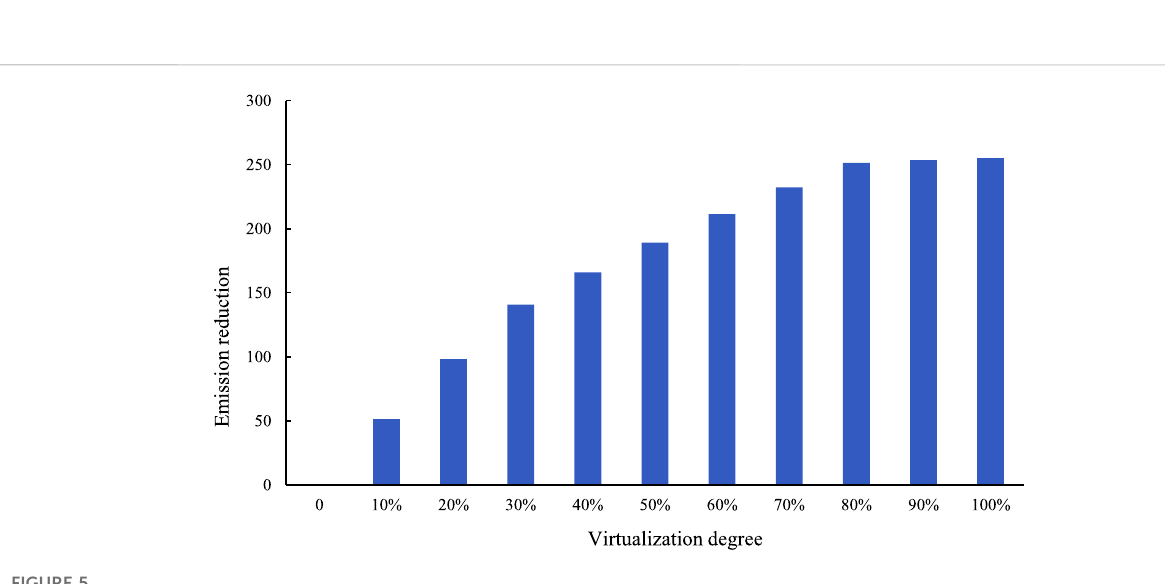
FIGURE 5 Traf fi c emission reduction under different degrees of virtualization (unit: ton).